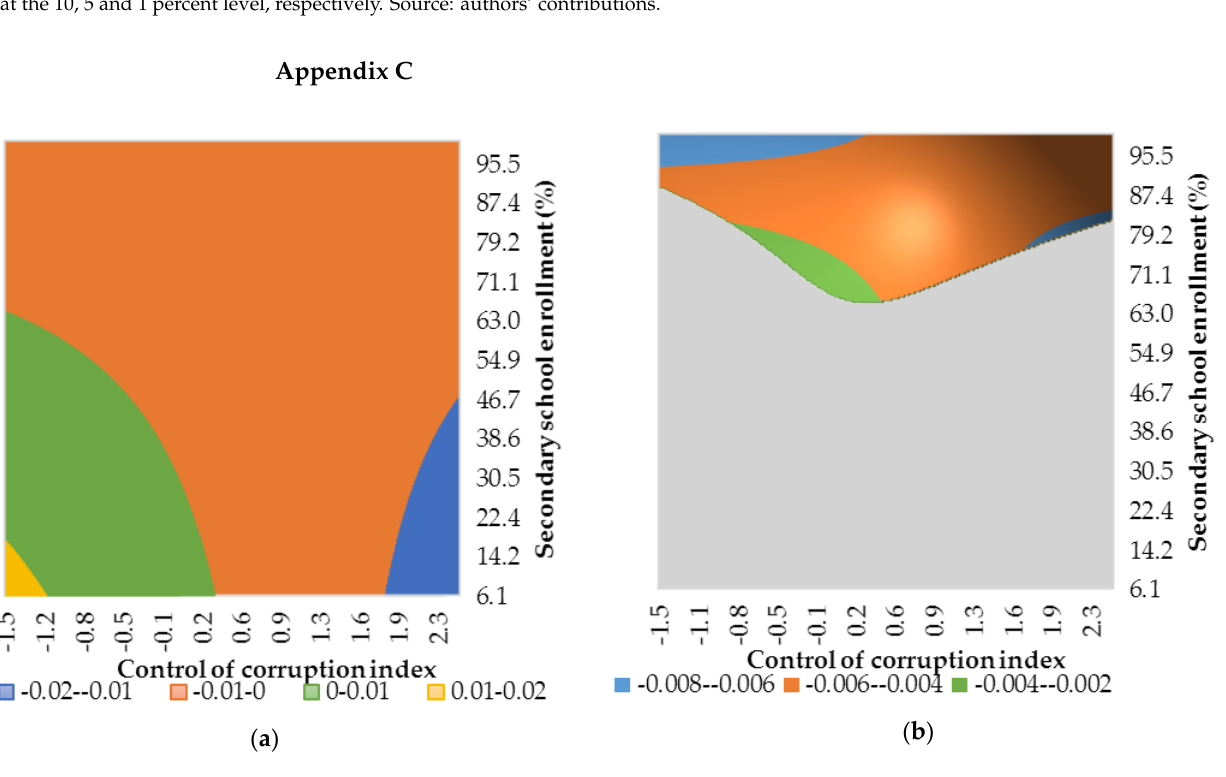
( b ) Figure A2. Conditional effect of financialisation on growth based on Est. 2 in Table A2. ( a ) Estimated conditional slope coefficient over the whole range of observed values for institutional quality and development level. ( b ) Estimated statisti- cally significant conditional slope coefficient. Gray represents a combination of institutional quality and development level for which effect of financialisation on growth is statistically insignificant. Source: authors’ contributions.